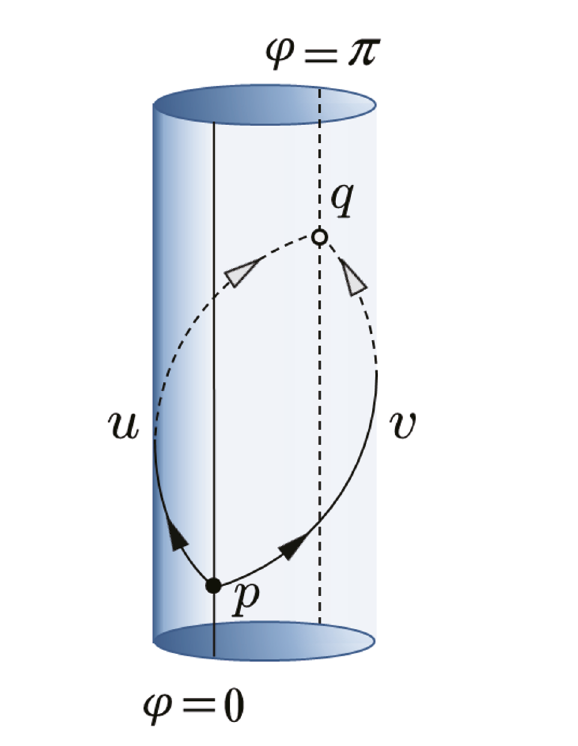
Figure 1 . Null rays on R 1 (cid:2) S 1 cylinder. Both null rays from a point p at ’ = 0 meet up round the back of the cylinder on a point q at ’ = (cid:25) . The null geodesic segment with the tangent vector @ v can only be achronal between p and q